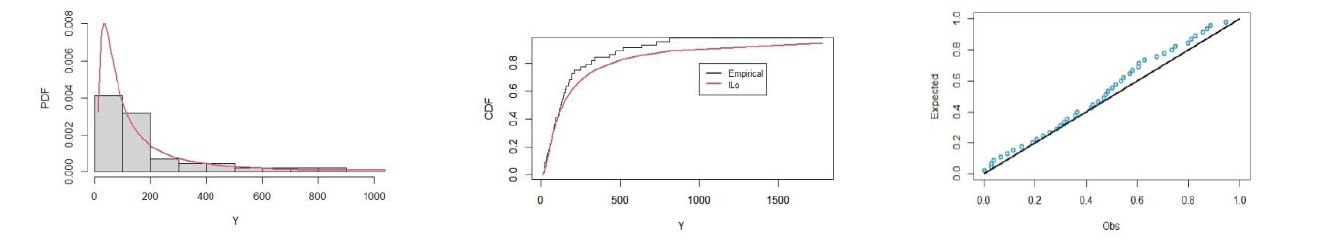
Figure 8. Estimated PDF, CDF, and PP plots of the Lo distribution for Y.